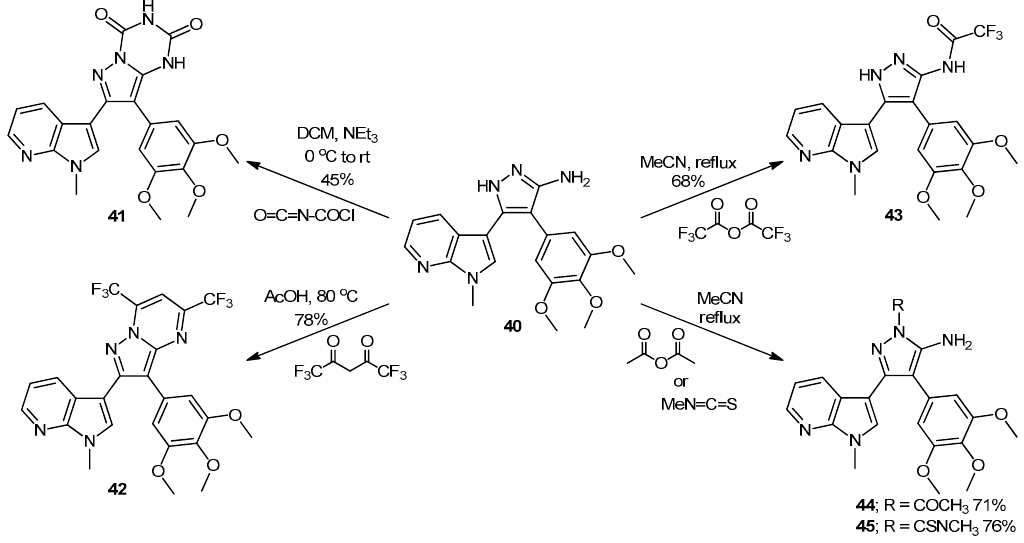
Scheme 6. Reaction of aminopyrazole 40 with bidentate and monodentate